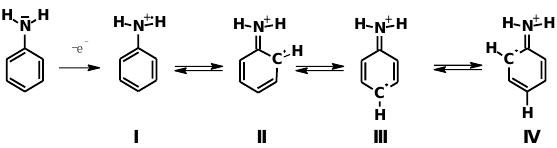
Figure 3. Canonical forms of aniline radical cation.